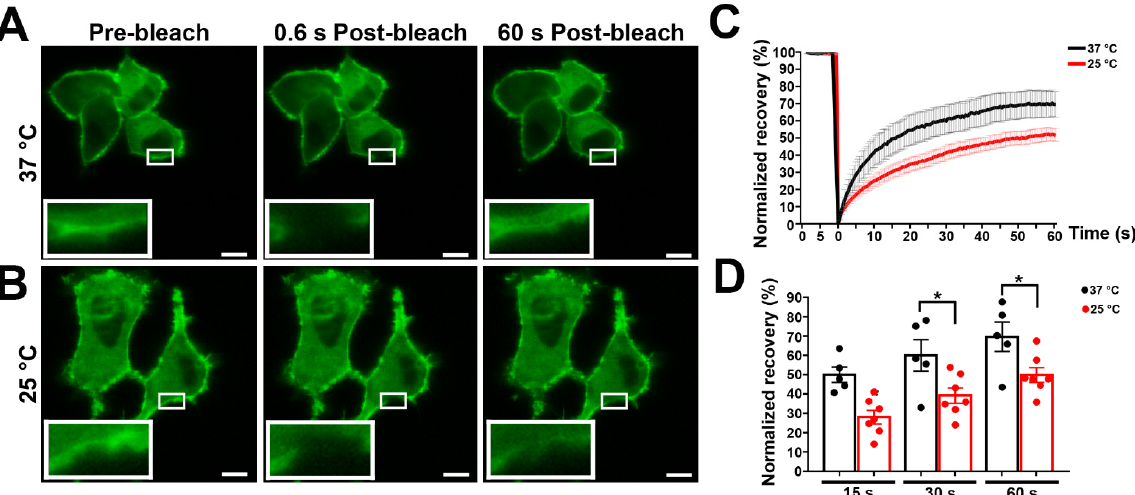
Figure 2. Effects of temperature on the lateral diffusion of mPanx1-GFP protein. N2a cells transiently expressing mPanx-1-GFP were subjected to FRAP at 37 ◦ C ( A ) and 25 ◦ C ( B ). Images were obtained at indicated time points after photobleaching. Magnification scale bars: 10 µ m; insets show FRAP regions. ( C ) Cumulative FRAP curves showing more rapid recovery at 37 ◦ C than 25 ◦ C. ( C , D ) Histograms of normalized FRAP recovery at 15, 30, and 60 s after photobleach. Each curve represents the average of 7–10 cells. p values were obtained using unpaired Student’s t test. Data collected over three independent repeats. Bars represent mean ± SEM. * p <